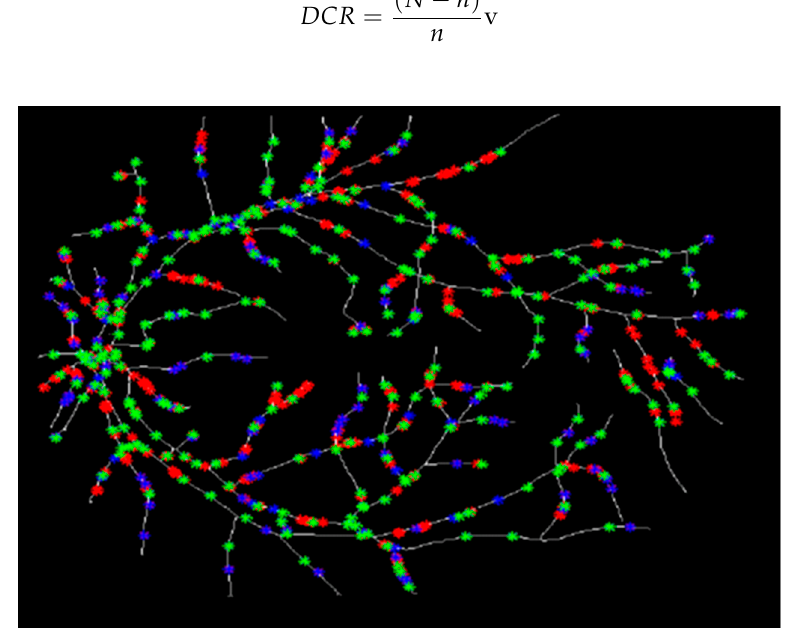
Figure 9. Determination of the characteristic points for three various values of ε . The red points show the characteristic points for ε = 0.5, the blue points depict the characteristic points for ε = 1, and the green points present the characteristic points for ε = 1.